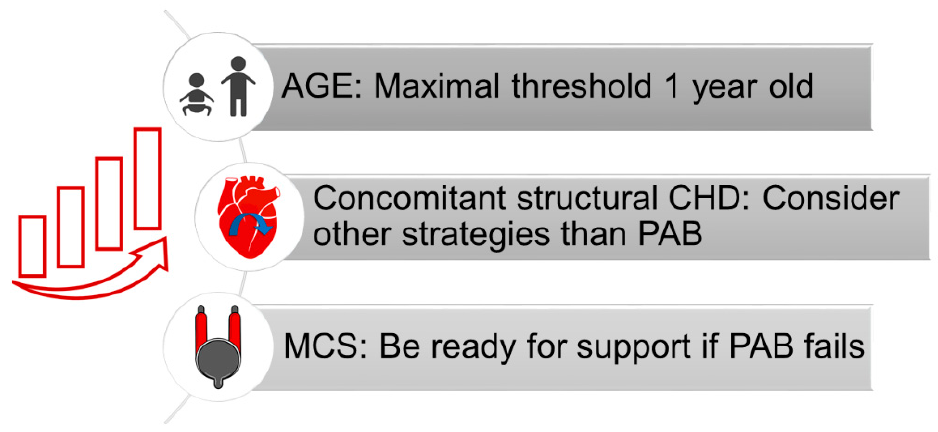
Figure 2. Proposed strategies to improve patients’ outcomes. CHD: congenital heart defect. MCS: mechanical support device. PAB: pulmonary artery